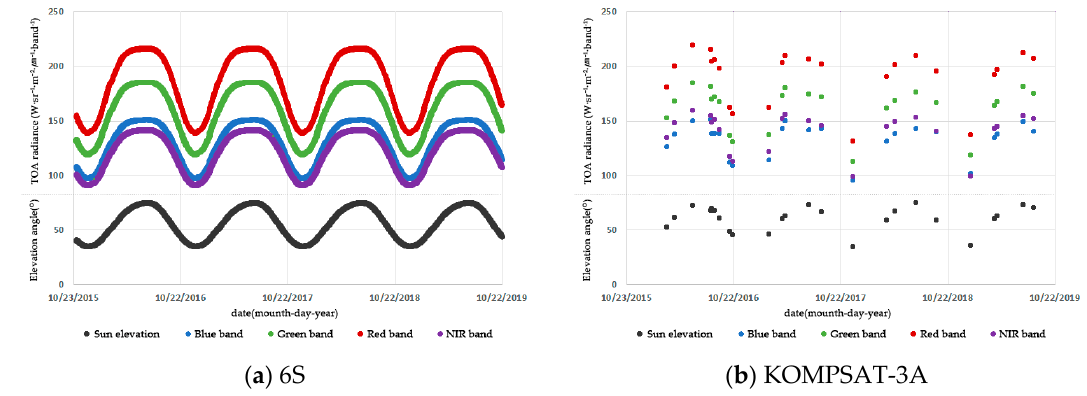
Figure 5. The TOA radiance trend in Libya-4 PICS obtained by 6S ( a ) and KOMPSAT-3A ( b ). Table 6. Comparison of TOA radiance accuracy assessment for simulated 6S and observed K3A TOA radiance using the initial absolute calibration coefficient [10].